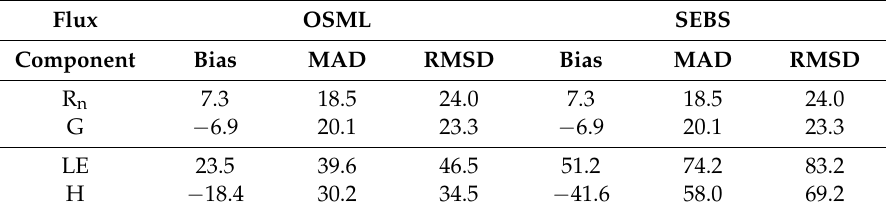
Figure 5. Validation of: net radiation R n ( a ); soil heat flux G ( b ); latent heat flux LE ( c ); and sensible heat flux H ( d ) during Landsat overpass on Day of Year (DOY) 174 and 182 of 2002. Results show that the estimated R n and G agree well with corresponding ground observations. Table 2. Summary of validation statistics for validating estimated surface fluxes (W/m 2